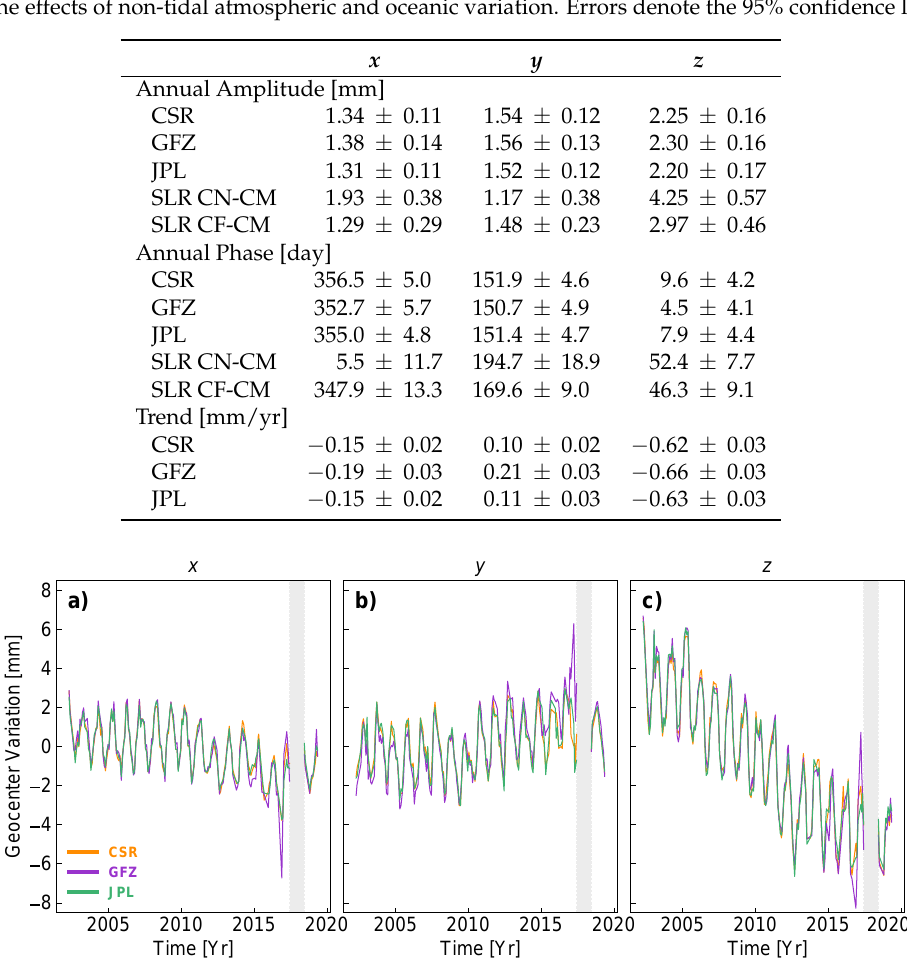
Table 1. Geocenter motion annual amplitudes, annual phase, and trends for 2002–2017 derived using satellite laser ranging (SLR) and time-variable gravity fields from the Center for Space Research (CSR), the German Research Centre for Geosciences (GFZ) and the Jet Propulsion Laboratory (JPL) corrected for the effects of non-tidal atmospheric and oceanic variation. Errors denote the 95% confidence level.